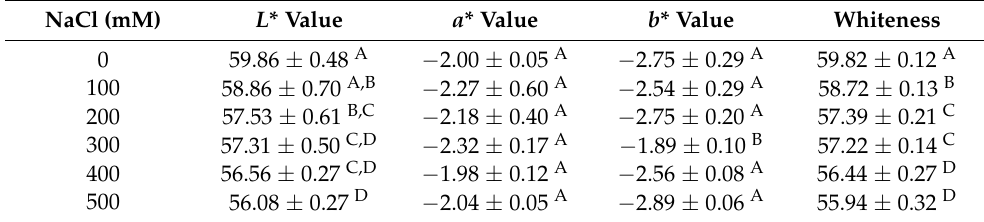
Table 4. Effects of NaCl concentration on the color of filled